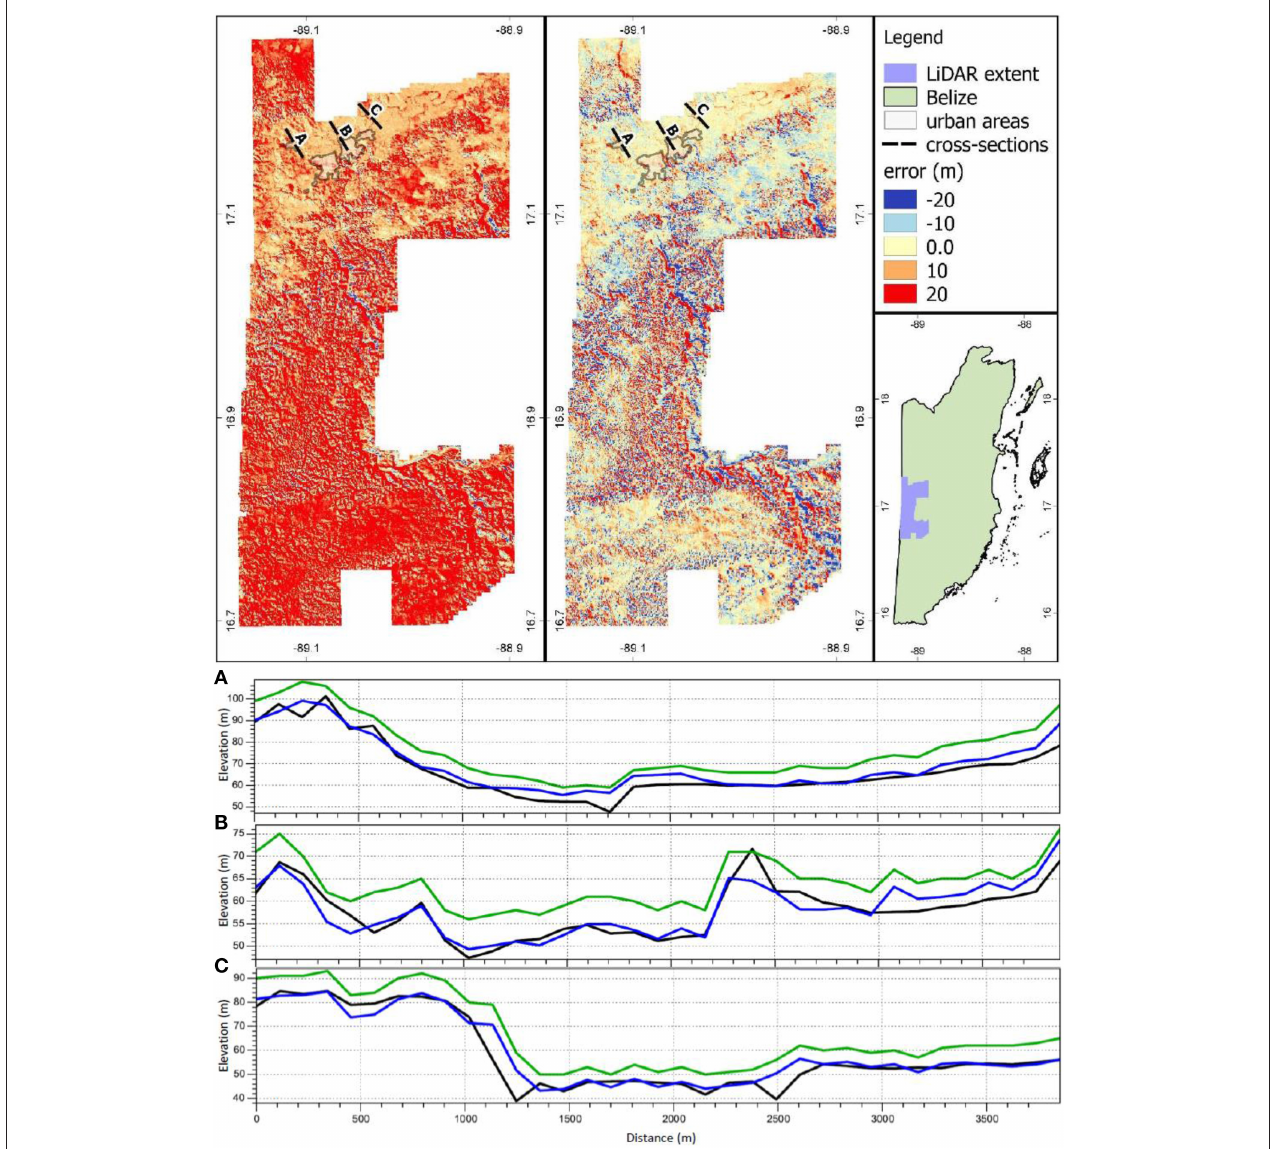
FIGURE 1 | Comparison of raw SRTM DEM to LIDAR (top left) and corrected SRTM to LIDAR (top center) for Western Belize. Cross-sections (A) , (B) , and (C) transect the Belize River valley and compare the LIDAR elevation profile (black) to the uncorrected SRTM profile (green) and corrected SRTM profile